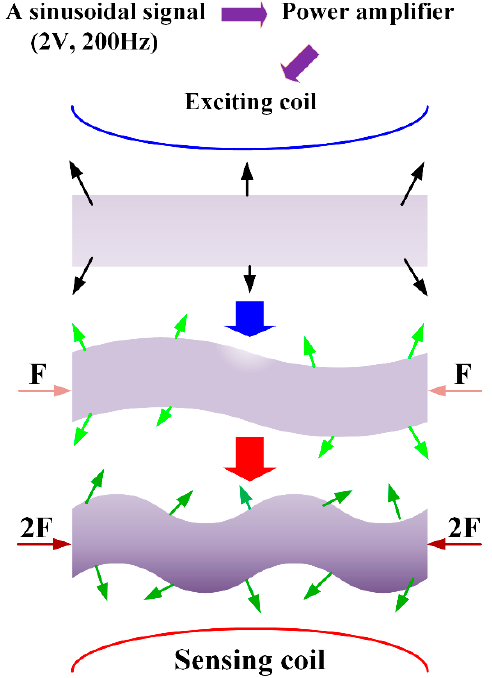
Figure 1. Working principle of the magnetoelastic-based (MB) sensor (working condition of MB sensor under F = 50 N and 2F = 100 N).